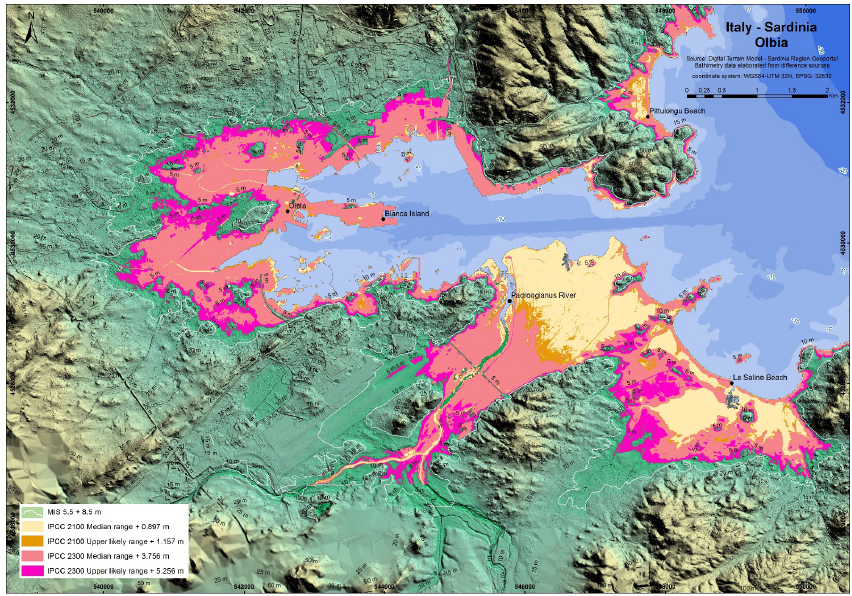
Figure 21. Map of Olbia plane, (see also Figure 2 for location). The potential submersion area, using IPCC projections at 2100 and 2300 .